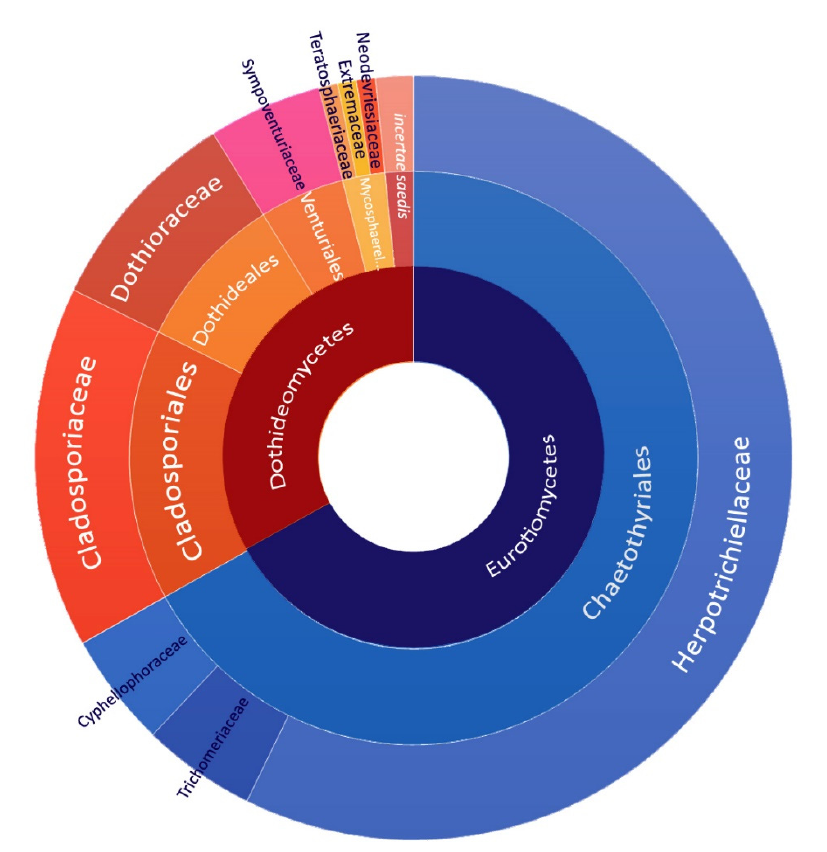
Figure 4. High taxonomic rank of 124 black fungi isolated from DCT (52), DPD (32) and GPD (40). Family (outer ring), order (central ring), and class (internal ring). Different shades of the same color in the chart indicate different families within each order and class.